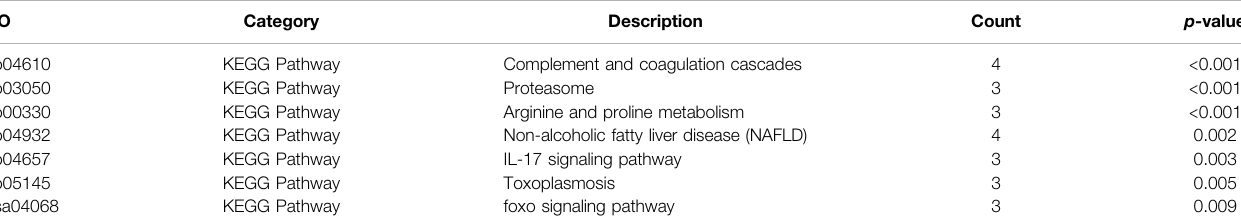
TABLE 2 | KEGG analysis of DEGs.